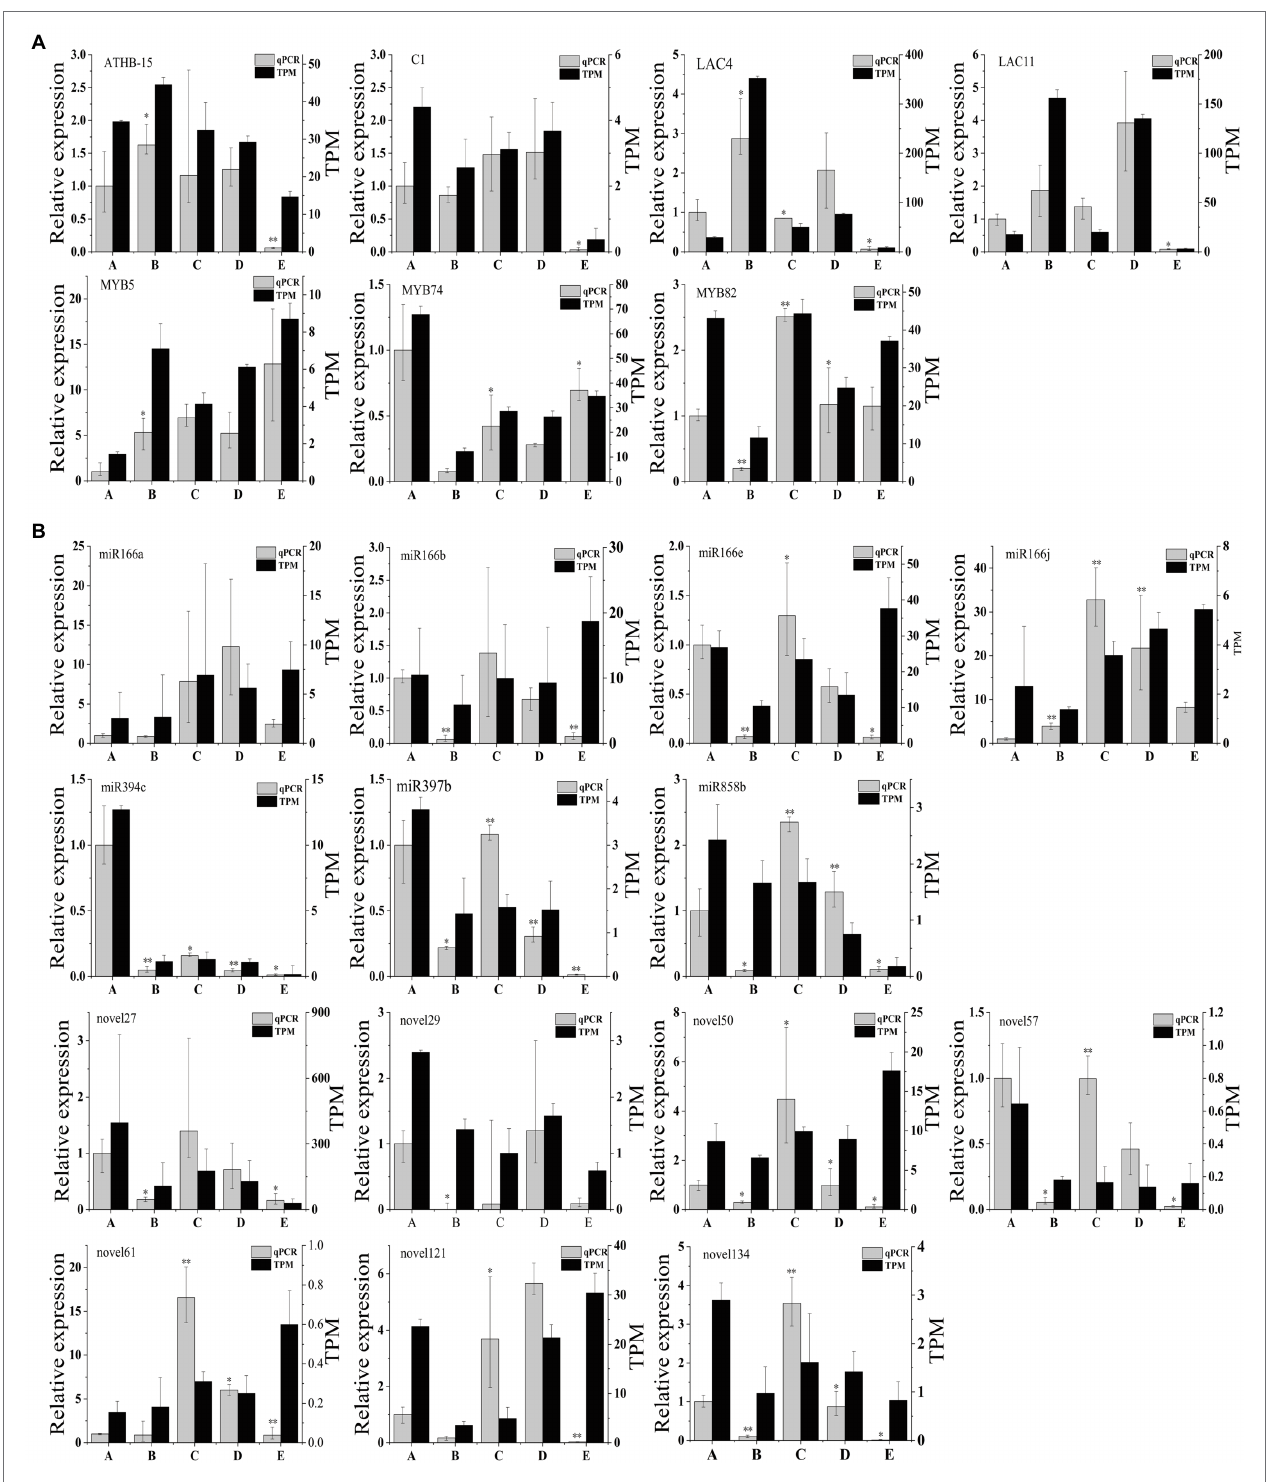
FIGURE 7 | (A) qRT-PCR validation of genes in C. fortunei . (B) qRT-PCR validation of miRNAs in C. fortunei . The x-axis presents the 5 stages, and the y-axes on the left and right represent the relative expression and TPM values of genes or miRNAs, respectively; n = 3, * p < 0.05, ** p <